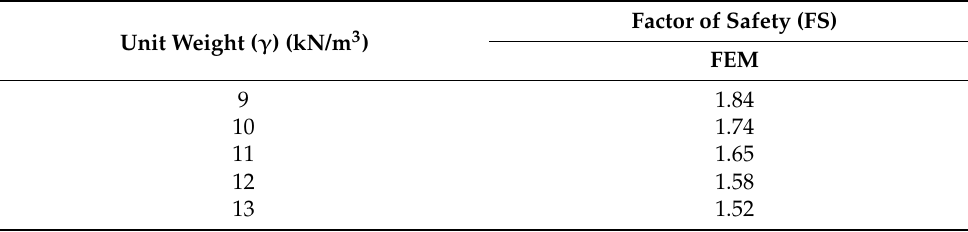
Table 12. Analysis results for different unit weight values (N = 4).